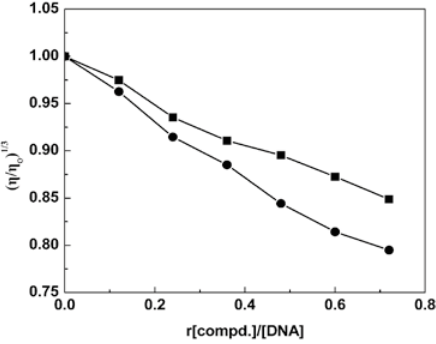
Figure 5. The effect of increasing the amount of La(III) complex ( ● ) and Gd(III) complex ( ■ ) on the relative viscosities of DNA. For the two complexes: [DNA] = 0.5 m mol L -1 ; r([Complex]/[DNA]) = 0.12, 0.24, 0.36, 0.48, 0.60, 0.72,